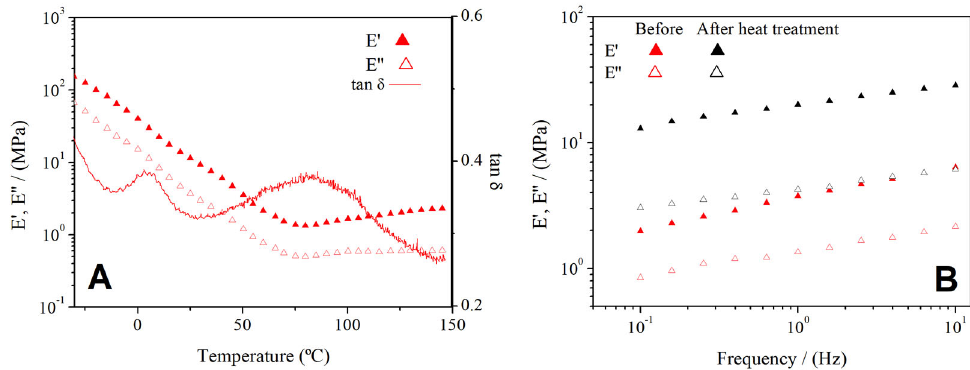
Figure 3. Evolution of elastic (E’) and viscous (E”) moduli with temperature ( A ) and with frequency before and after heat treatment ( B ) for the blend with a RO/GLY ratio of 60/40.